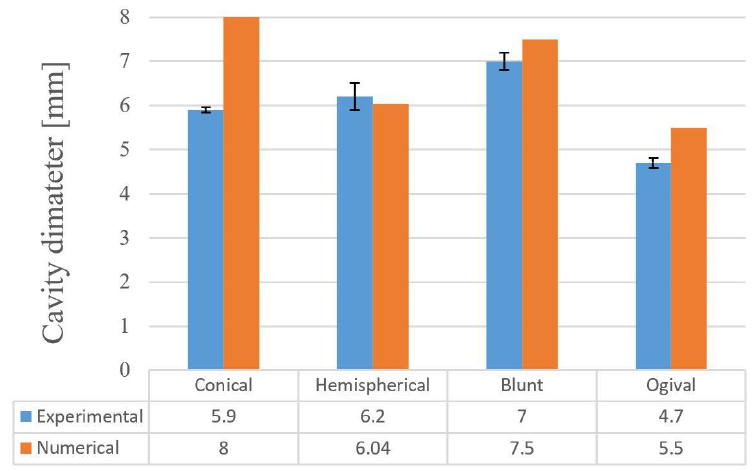
Figure 10. Comparison of cavity diameter formed after impact.